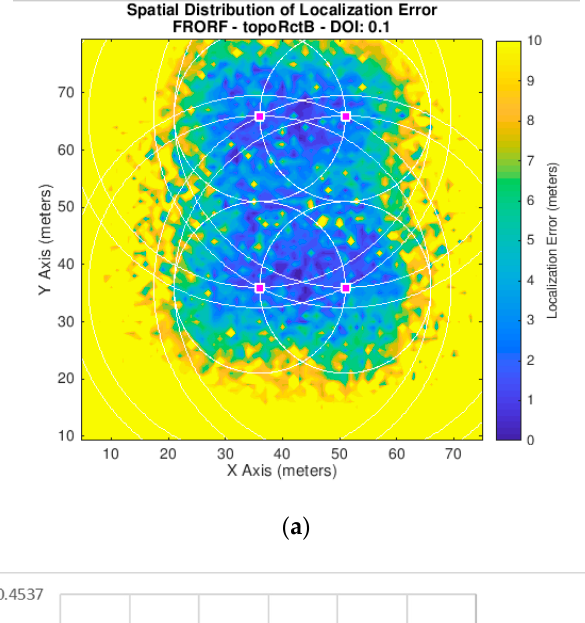
Figure 19. Experiments mean error results for scenario 1. ( a ) Scenario 1 in the simulator (p -value = 0.5); ( b ) scenario 1 in the outdoor set-up.